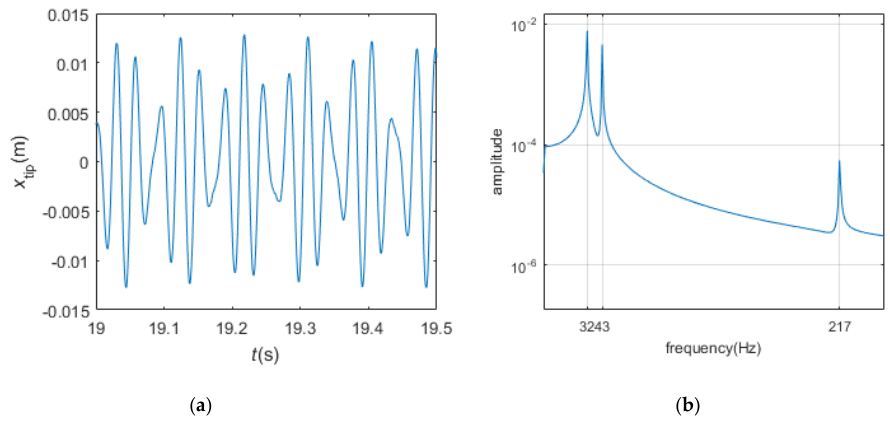
Figure 16. ( a ) The steady-state response of the blade tip; ( b ) the frequency spectrum of the blade tip.